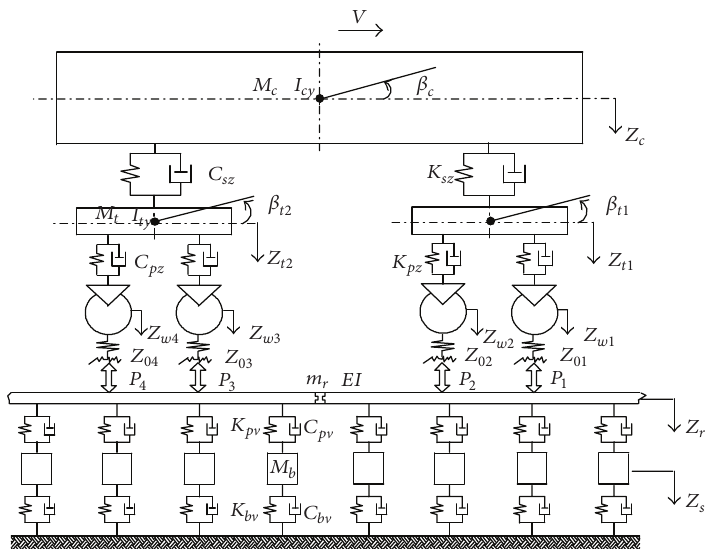
Figure 2: Lateral view of the dynamic model.